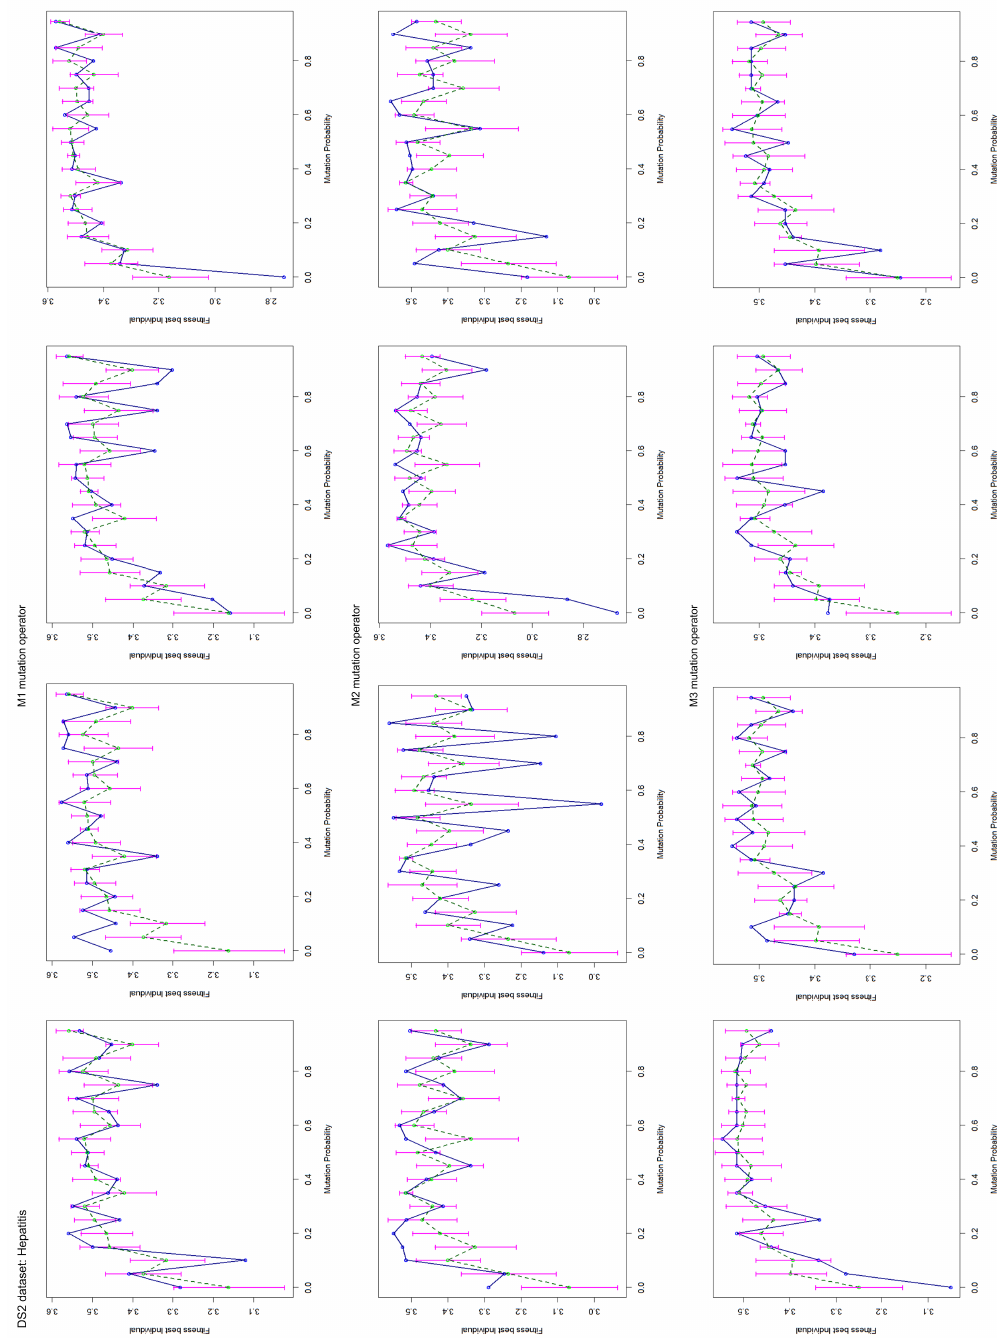
Figure A2. Mutation tests for mutation operators M1, M2, and M3 for the DS2 dataset. Each row of four graphics in the figure corresponds to the same mutation operator and each graphic corresponds to 20 executions of the evolutionary method for 20 mutation probability values with step 0.05. The blue line represents each fitness value for each mutation value. The green line represents the mean values from the four graphics in the same row and pink lines state the standard error